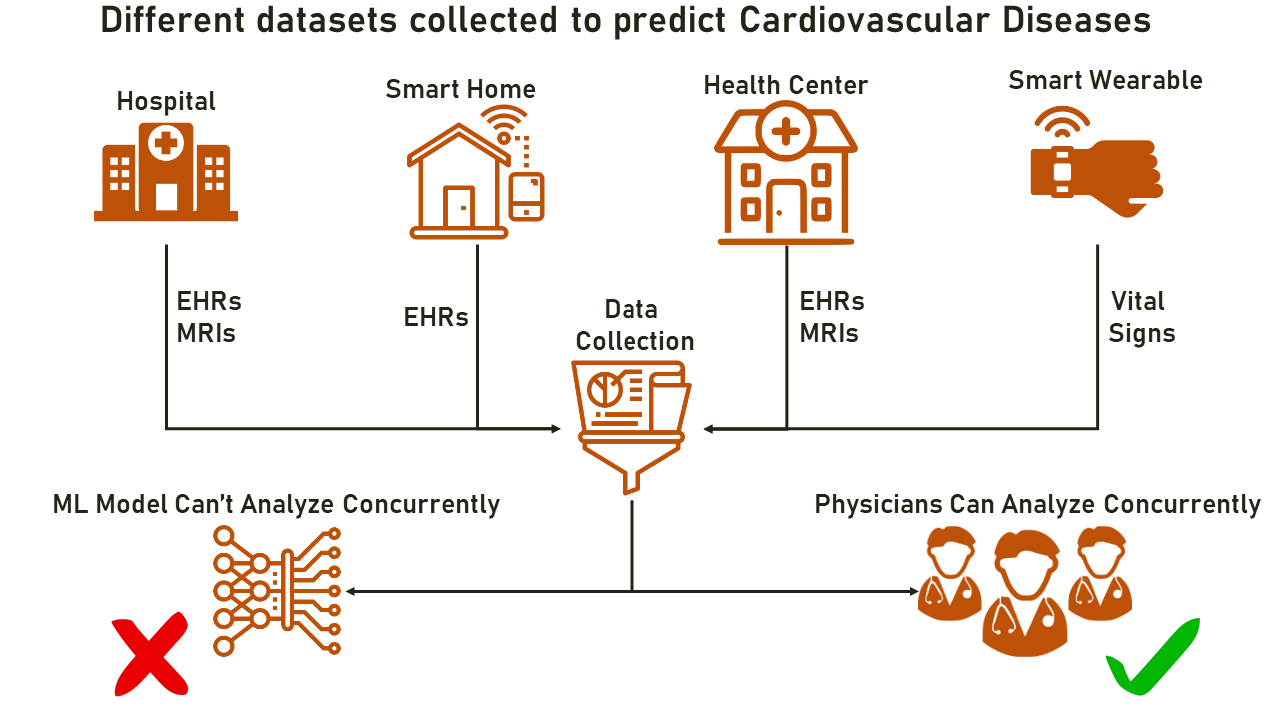
Figure 2. Prediction of CVDs with heterogeneous data—a